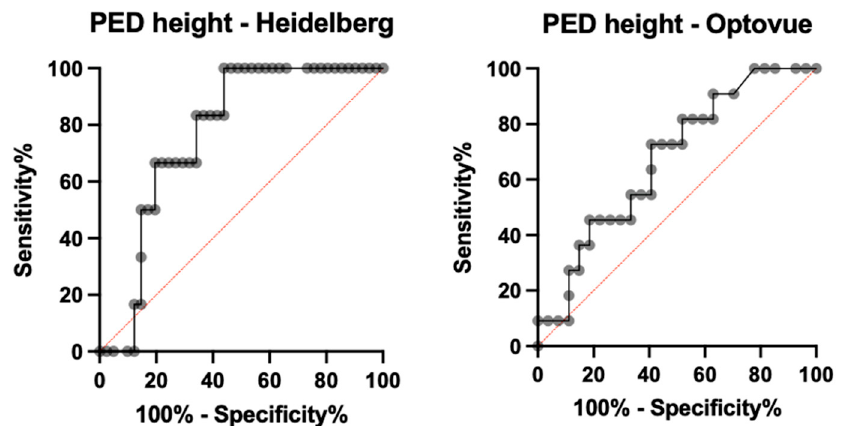
Figure 5. ROC curves for sensitivity and specificity of PED height in the prediction of MNV unpre- dictability with OCTA when measured with Heidelberg ( left side ) and Angiovue ( right side ) OCT B scan. OCT = optical coherence tomography; PED = pigment epithelial detachment; ROC = receiver operating characteristics curves.